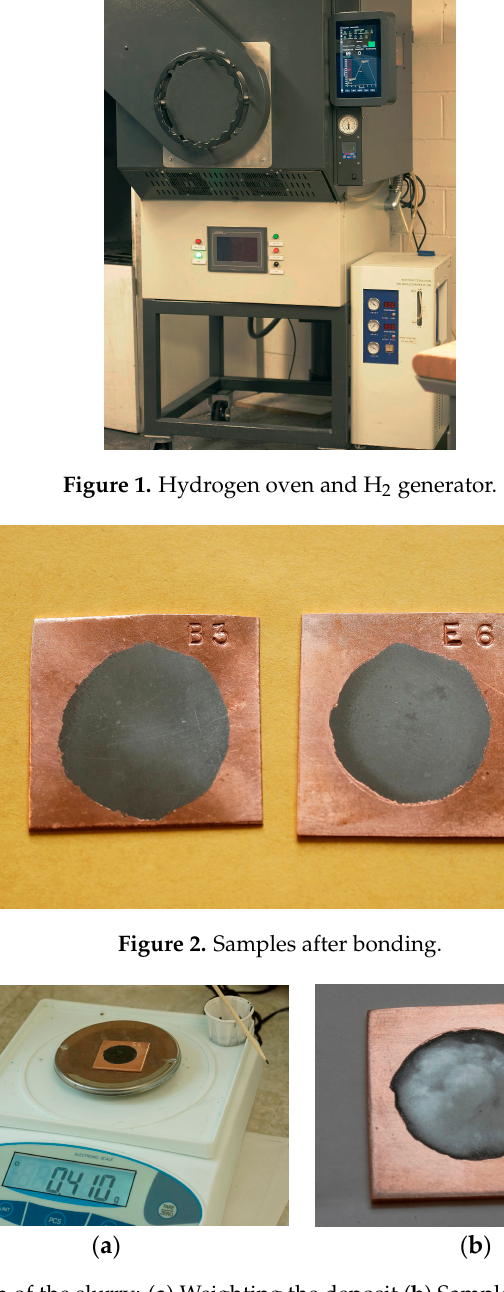
Figure 2 . Hydrogen oven and H 2 generator. Figure 3 . Samples after bonding. 3. Results Sixty-two samples were prepared and tested. The weight of the deposited slurry was chosen to give a final thickness of the metal cladding—after sintering and bonding—to be between 40 μ m and